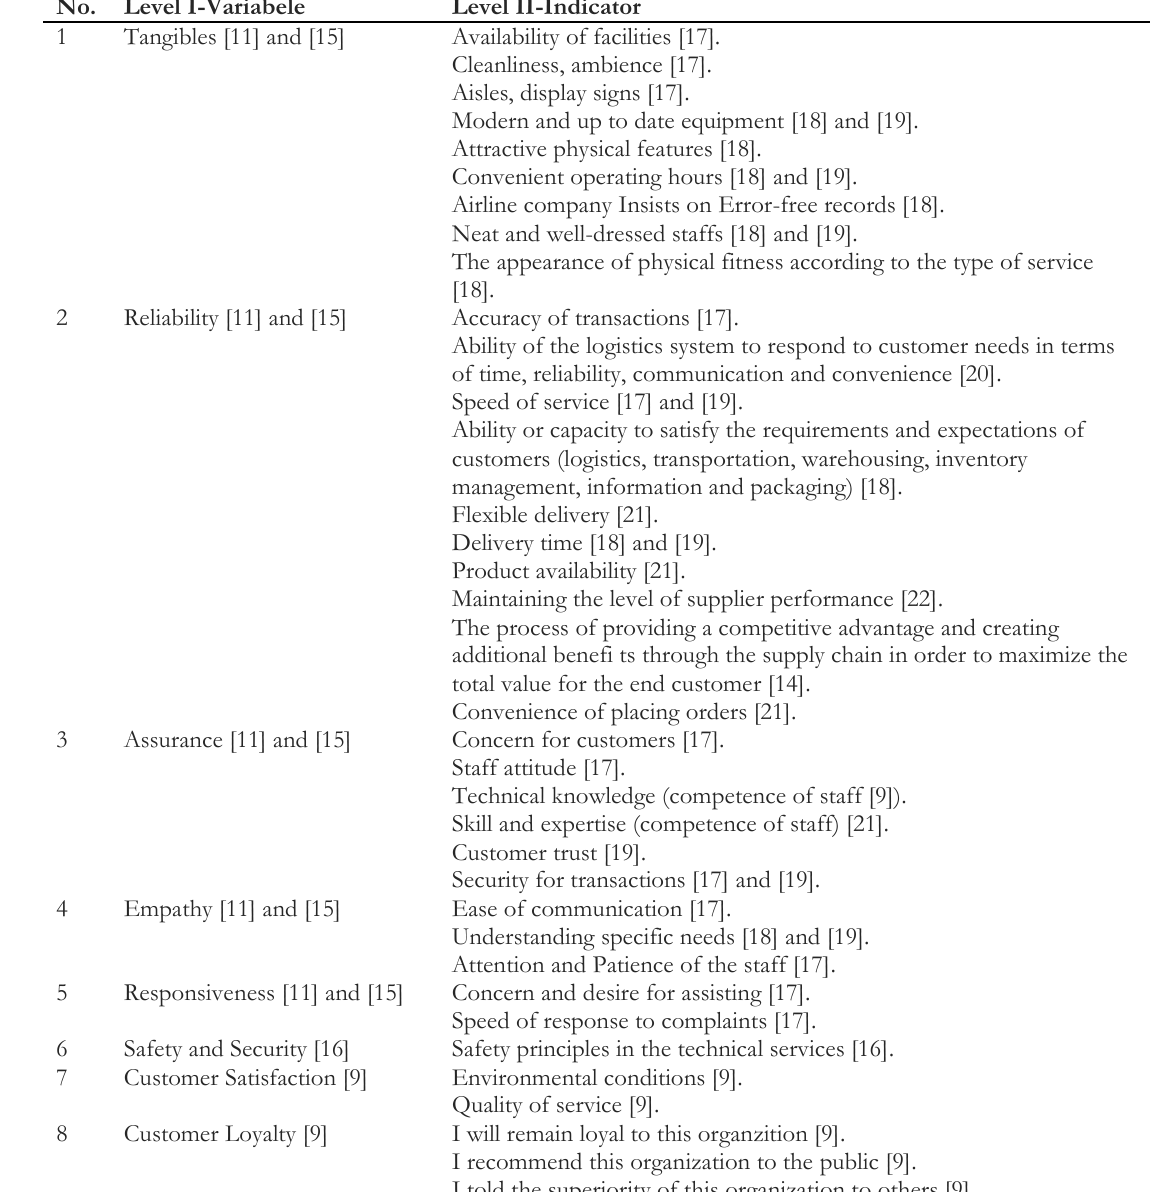
Table 1. Analysis of the quality gap support services dimensions list for the reverse engineering in airlineindustry (RL AIRQUAL).